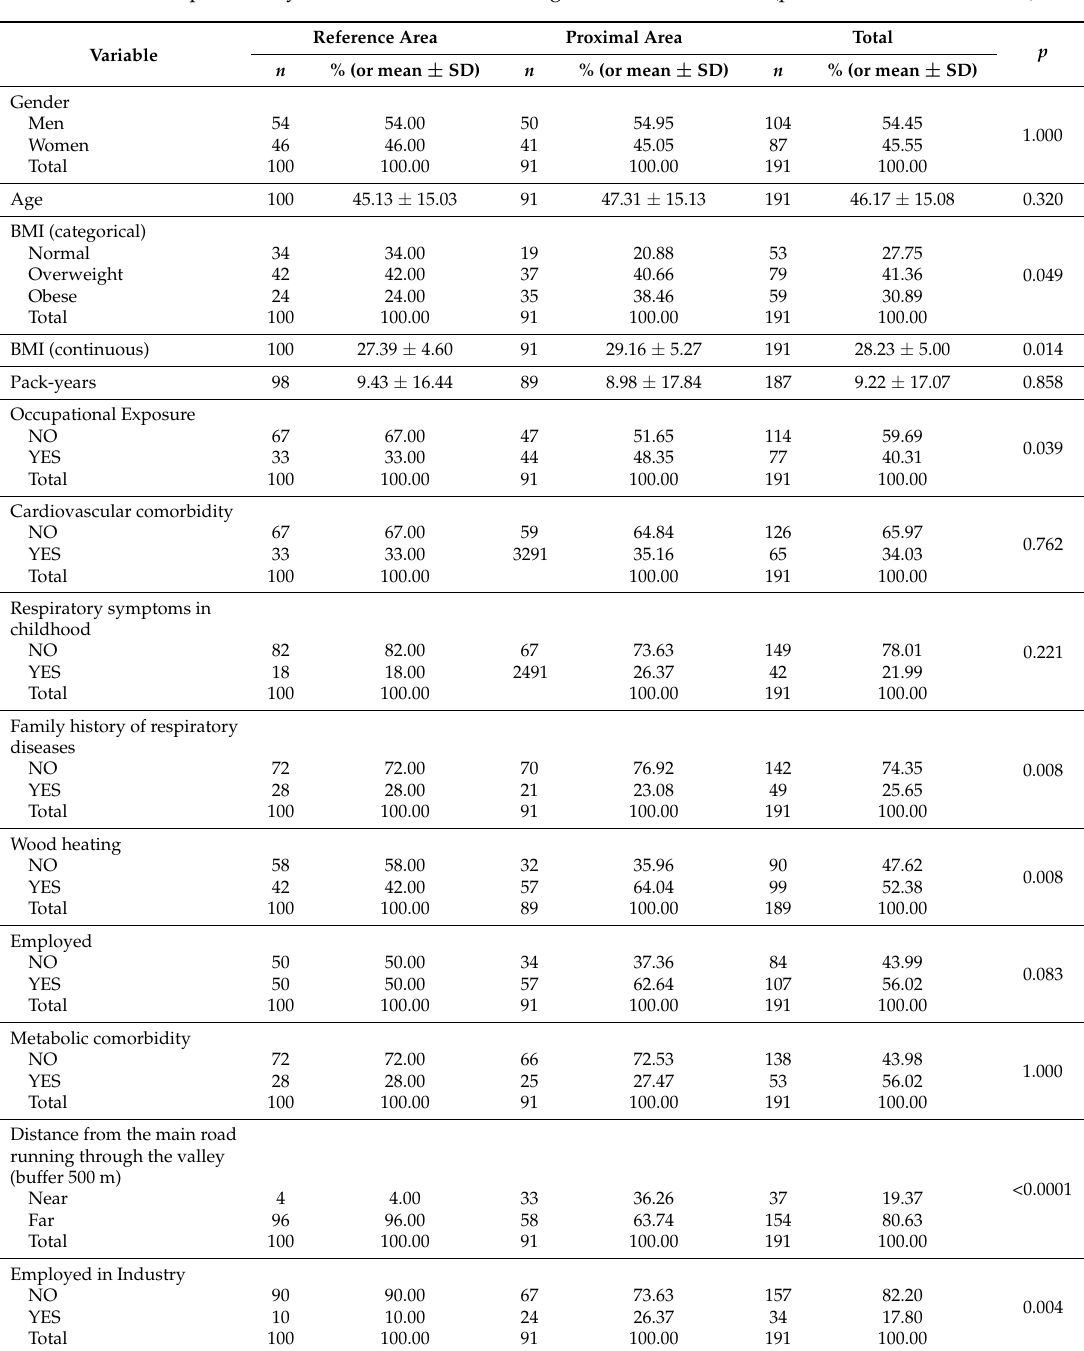
Table 1. Descriptive analysis of risk factors according to the residence area (proximal versus